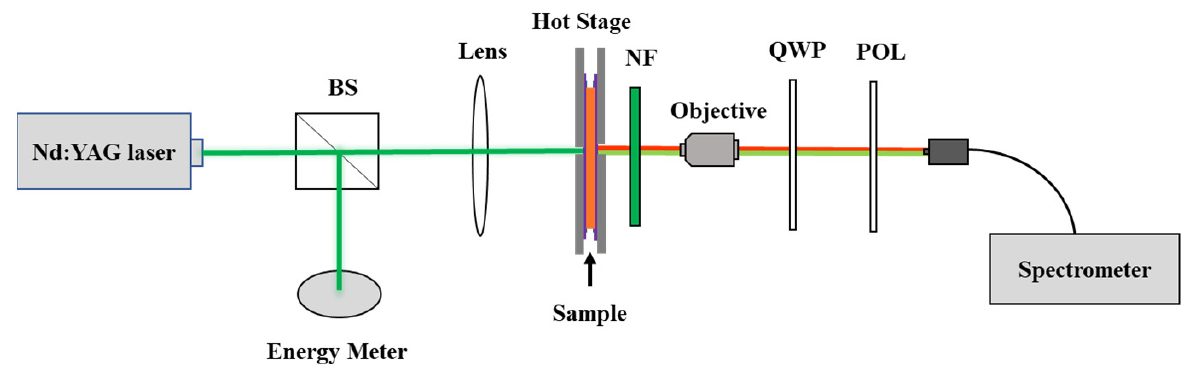
Figure 2. Schematic diagram of the experimental setup: BS: beam splitter; NF: notch filter; QWP: quarter-wave plate; POL: polarizer.